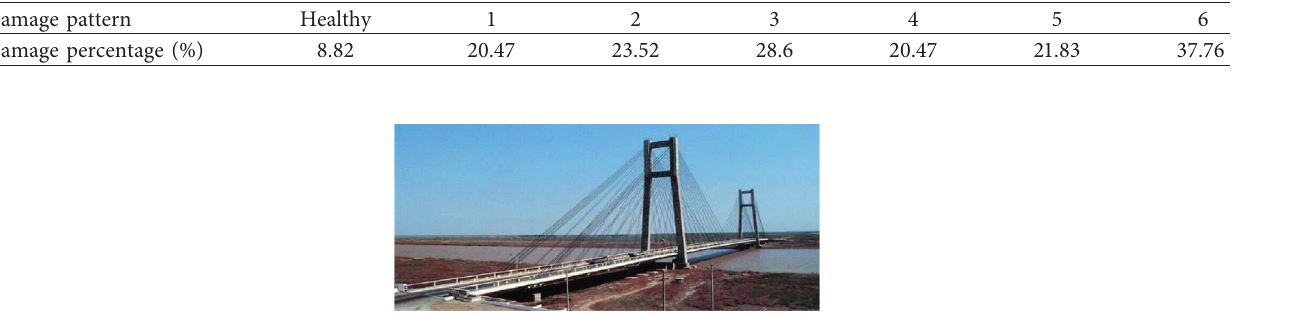
Figure 9: Tianjin Yonghe bridge